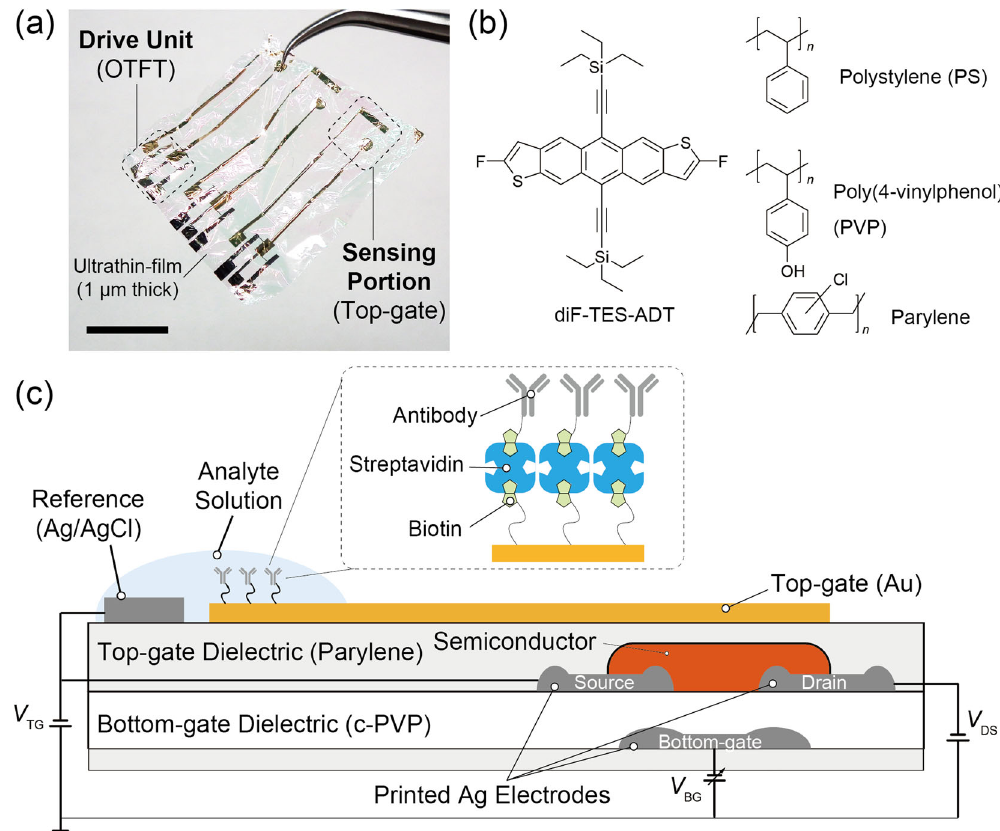
Fig. 1 Flexible OTFT-based immunosensor. a Photograph of the fabricated device. The scale bar is 1 cm. b Chemical structures of the utilized materials in this study. c Schematic illustration of an OTFT-based immunosensor on a 1- μ m-thick fi